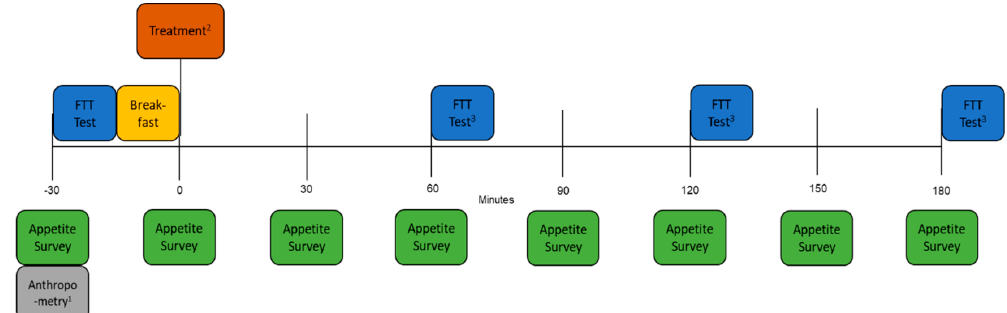
Figure 2. Outline of study design. FTT: fat taste threshold; 1 Anthropometry was only measured during the first day of testing; 2 Treatment was either the oleic acid (OA) or control mouth rinse, which were randomly allocated to each participant; 3 Subsequent FTT tests after the first were only measured on the first two days of testing.